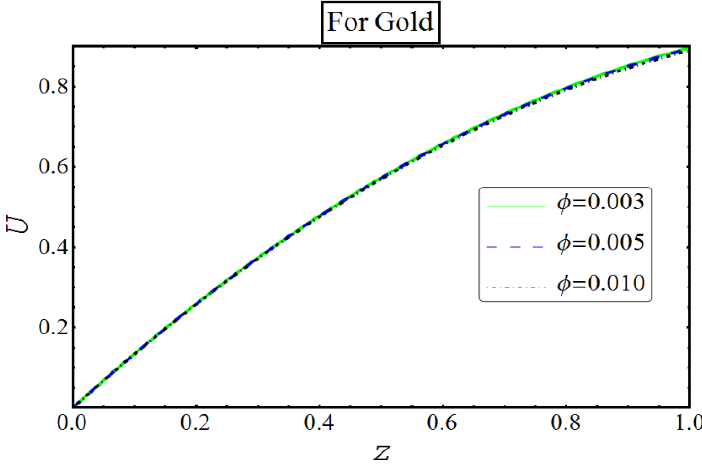
Figure 12. Effects of concentration particles on radial velocity with gold particles.